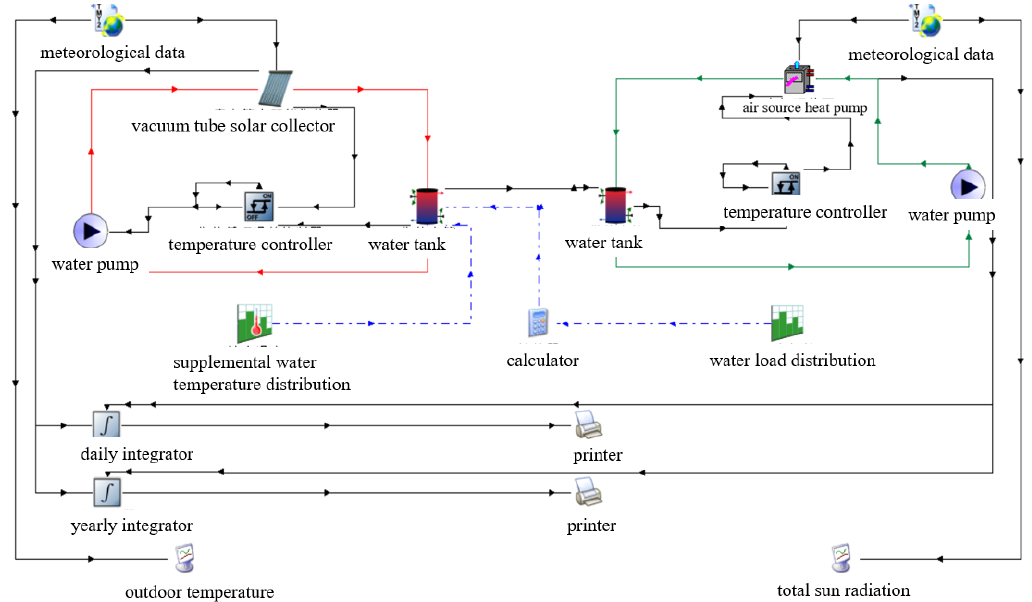
Figure 11. The simulation model of SA-ASHP water heating system in TRNSYS.